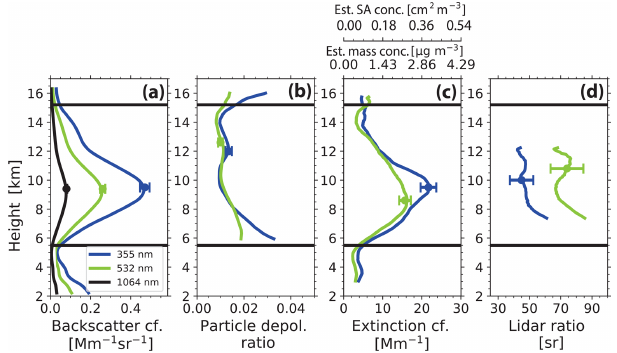
Figure 11. Profiles of optical properties (4.5h mean values) of the wildfire smoke layer on 25 October 2019 at 09:30–14:00UTC (cirrus-free period; Fig. 9). Base and top heights of the smoke layer are indicated by black horizontal lines. (a) Particle backscat- ter coefficient at three wavelengths, (b) particle linear depolariza- tion ratio at 355 and 532nm, (c) smoke extinction coefficient at 355 and 532nm, and (d) respective smoke extinction-to-backscatter ra- tio (lidar ratio) are shown. The vertical resolution is about 450m (backscatter and depolarization ratio), 2000m (extinction coeffi- cient), and 2400m (lidar ratio). Estimated mass concentration and surface area concentration (obtained from the conversion of the 532nm extinction coefficients) are given in addition (upper x axis in c ). Error bars (1 standard deviation) indicate the estimated uncer- tainties in the observations around layer centre. Depolarization ra- tios and extinction coefficients close to and around the layer bound- aries have to be interpreted with caution.